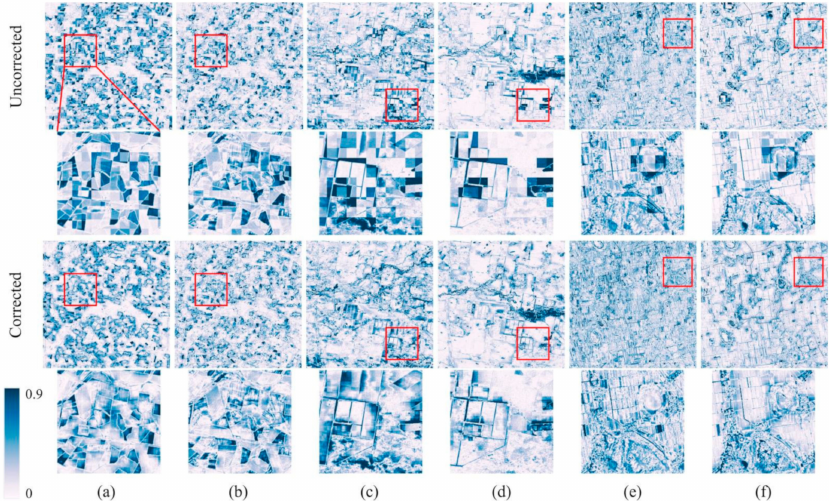
Figure 14. The absolute difference between MODIS NDVI (before and after correction) and the corresponding Landsat NDVI in the three experimental areas. ( a ) 4 December 2001, ( b ) 12 January 2002, ( c ) 26 November 2004, ( d ) 12 December 2004, ( e ) 26 June 2018, and ( f ) 28 July